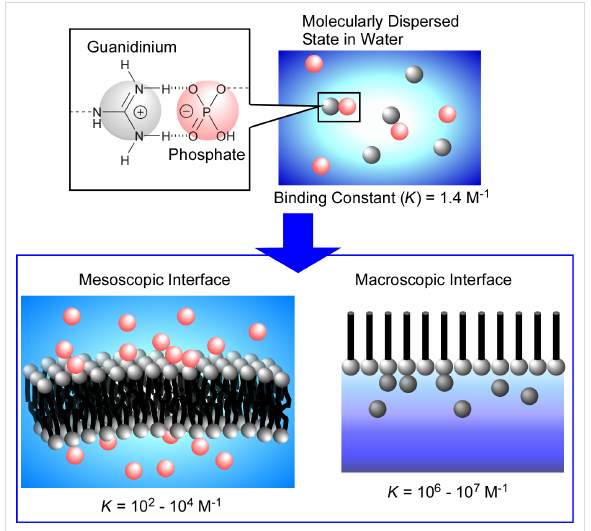
Figure 3: Systematic studies on binding constants for phosphate and guanidinium in different aqueous environments: 1.4 M − 1 dispersed in water; 10 2 to 10 4 M − 1 at disorganized mesoscopic interfaces; 10 6 to 10 7 M − 1 at the macroscopic air–water interface. Adapted with permis- sion from [144], copyright 2019 American Chemical